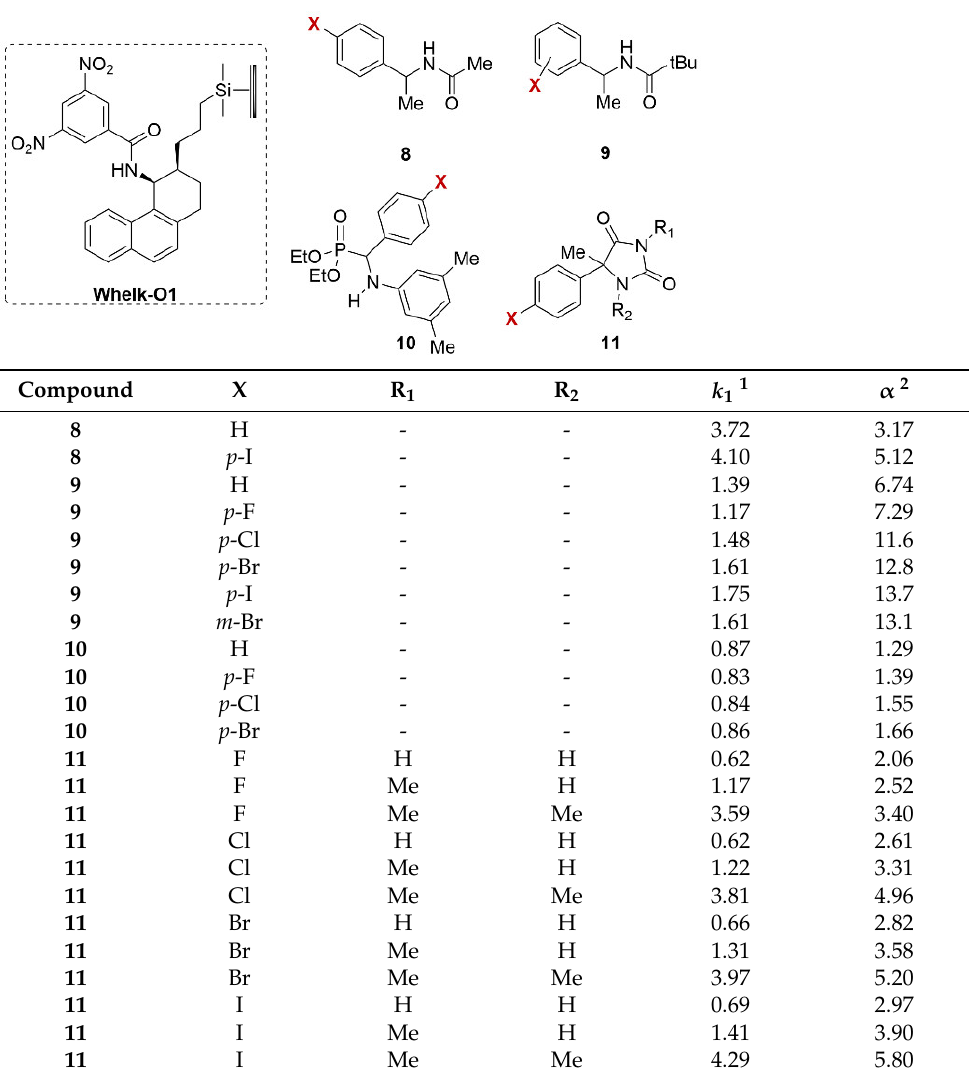
nonaqueous organic mobile phases are used. The more polarizable the halogen, the greater the ef- fect ” [50]. Table 1. Halogen effect on the enantioseparation of derivatives 8 – 11 on Whelk-O1 [50,51].